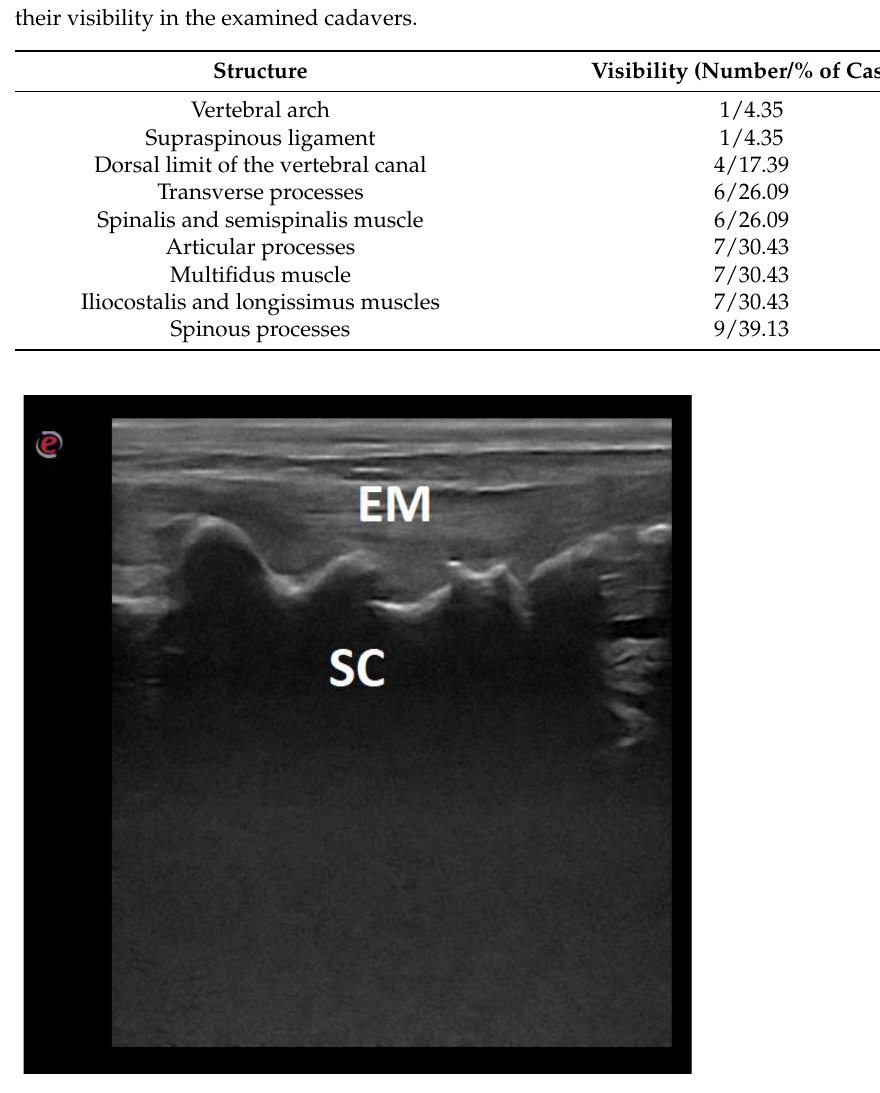
Figure 5. Ultrasonographic image of the lumbo-sacral spine of a dog in the longitudinal midline plane. EM — epaxial muscles; SC — sacral crest.